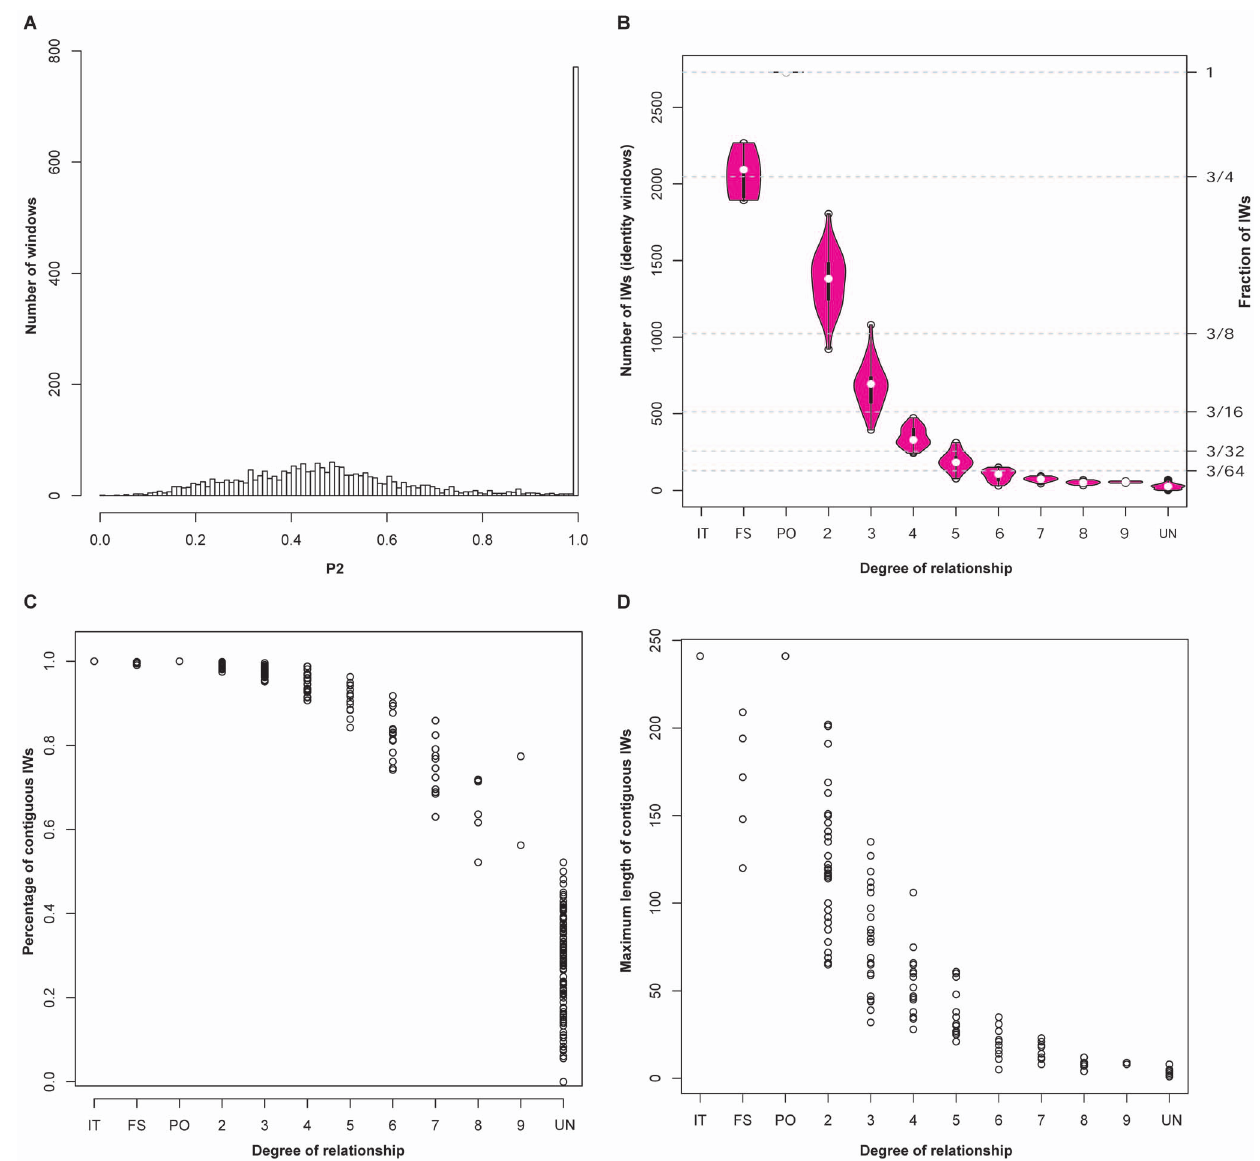
Figure 2. IBS percentage in different relationships of simulated families. For this visualization, the sequencing error (SE) parameter was set to zero. (A) Distribution of P2 in an example sibling pair. Siblings have much of the genome that is easily detectable as IBD2, which GRAB detects through a large number of windows with a very high P2 statistic. (B) Number of identity windows (IWs) between pairs of individuals, decreasing with increased relationship degree. (C) Percentage of contiguous IWs. A contiguous IW is any IW adjacent to another IW. Unrelated individuals have fewer contiguous IWs than relatives. (D) Maximum length of a set of contiguous IWs. This length tends to be shorter in distant genetic relationships than close relationships. IT: identical twin. FS: full sibling. PO: parent offspring. UN: unrelated individuals. UD: unknown